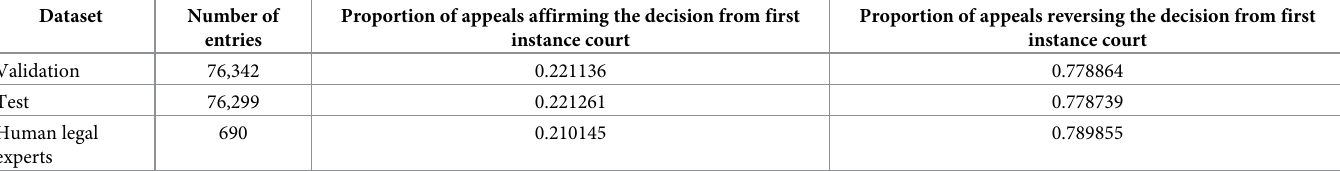
Table 5. Size and label distribution for the validation, test and human experts’ datasets.